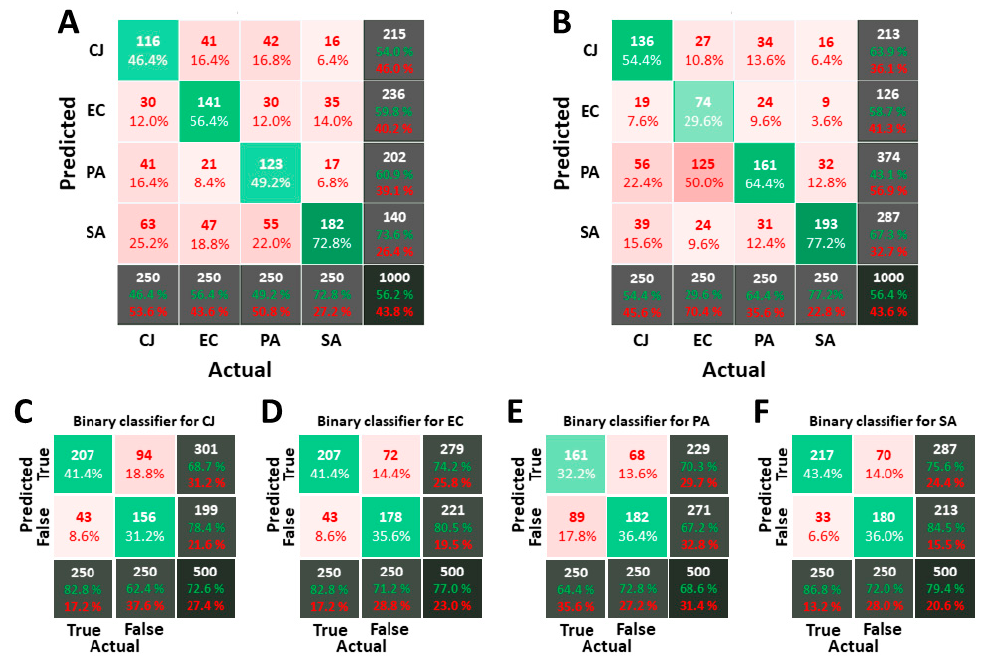
Figure 8. Confusion matrices for classifiers calculated on images acquired in PBS. ( A , B ) are the confusion matrices obtained with the 1-over-4 strategy and RF for ( A ) and SVM for ( B ). ( C – F ) are respectively the binary classifiers for C. jeikeium , E. coli , P. aeruginosa and S. aureus . The way to interpret confusion matrices is explained in Material and Methods. For the 1-over-4 strategy, the standard deviation over 50 runs is about 2.3% on the overall score for RF and 3.7% for SVM and about 3.8% on individual scores for RF and 4.1% for SVM. For the binary strategy, the standard deviation is about 1.2% for the overall score for RF and 2.1% for SVM and 3.7% for the score of true positive for RF and 3.5% for SVM. Table 3. Comparison of the individual scores of each type of bacterium in isopropanol for the Ta- ble 1. over-4, binary, tournament. The cell background colour varies from red to green through orange and yellow depending on the percentage of bacteria correctly identified. The colourbar is not linear. Red corresponds to percentages below 5%, orange around 10%, yellow around 20% and green above 30%.